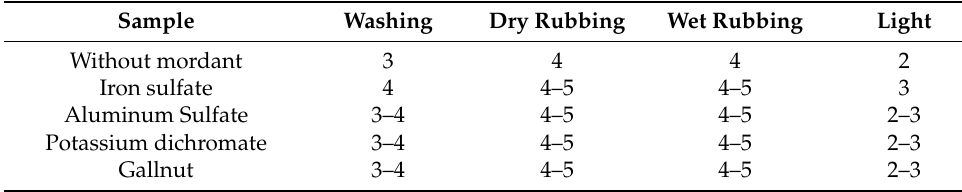
Table 5. Fastness Table 5. Fastness results. Table 5. Fastness results. Table 5. Fastness results.